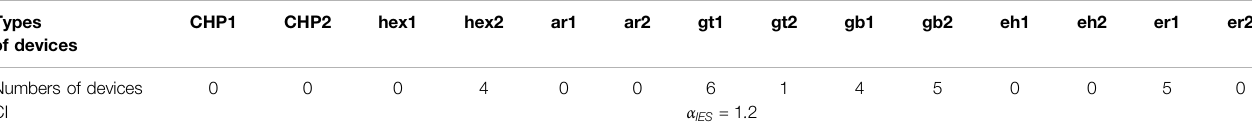
TABLE 5 | Optimal planning results.